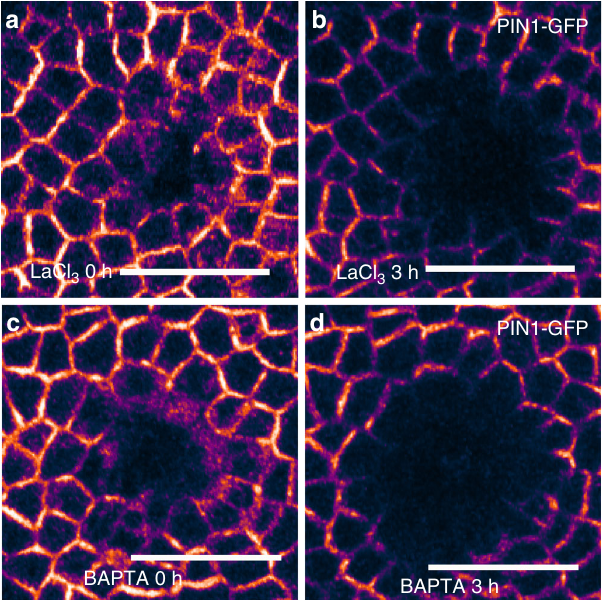
Fig. 4 The PIN1 mechanical response is initiated within 5 min of stimulus and is not reversed by subsequent Ca 2 + inhibitor treatments. a , b PIN1-GFP behaves similarly to an untreated control at 3 h when pipette-mediated cell ablation precedes (by 5 min) the application of 5 mM LaCl 3 (which lasts 15 min with no subsequent washout). c , d PIN1-GFP behaves similarly to an untreated control at 3 h when pipette-mediated cell ablation precedes (by 5 min) the application of 2 mM BAPTA (which lasts 10 min with no subsequent washout), as in a , b . a – d , Scale bar: 20 µ m. LUT is gem in